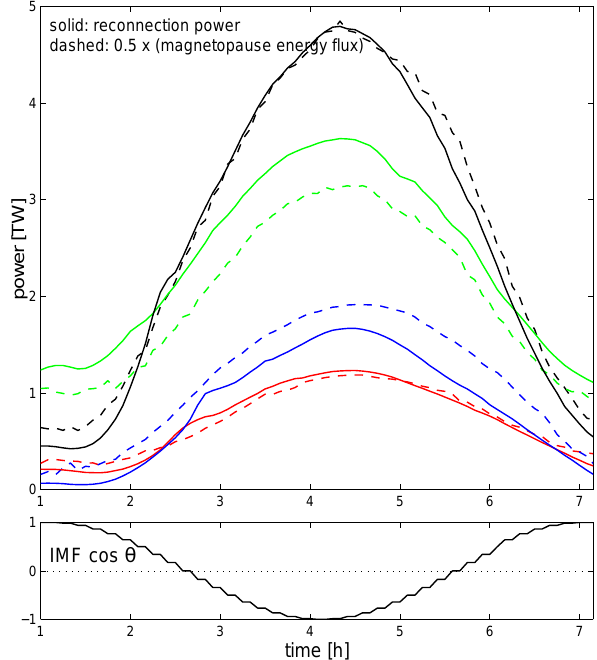
Fig. 8. Magnetotail reconnection power, in watts, in the four differ- ent IMF rotation runs (solid lines). Black: large P, large B. Green: large P, small B. Blue: small P, large B. Red: small P, small B. The dashed lines show the net energy flow into the magnetosphere through the magnetopause, scaled by a factor of 0 .